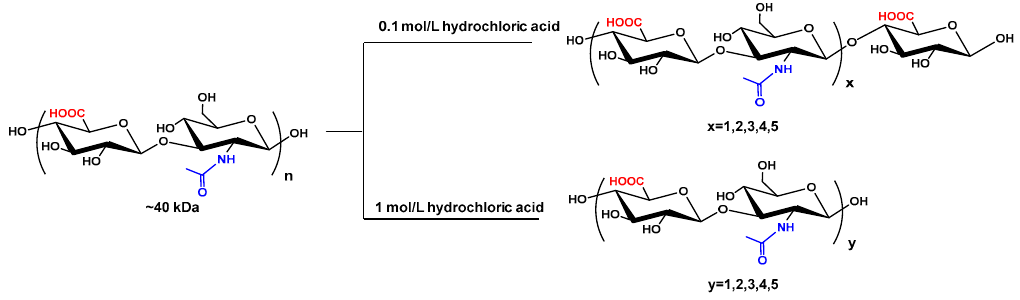
Figure 4. Preparation of HAOs. The purified HA (~40 kDa) was cleaved with hydrochloric acid at concentrations of 0.1 and 1 mol/L and then fractionated by GPC to obtain the even- and odd-numbered oligosaccharides, respectively.